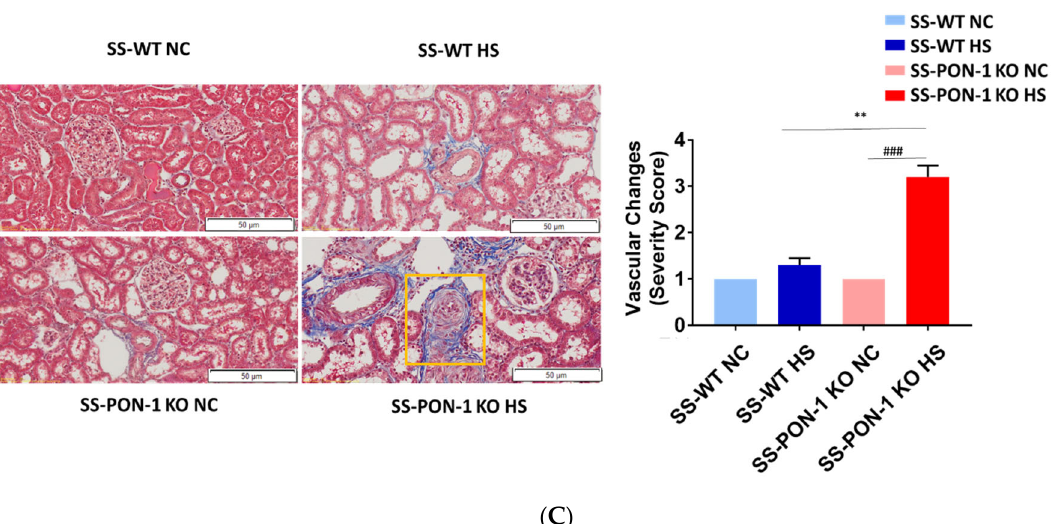
Figure 6. Targeted mutation of paraoxonases-1 leads to a significant increase in histological changes accompanying renal damage; ( A ) glomerular sclerosis, ( B ) tubular necrosis, and ( C ) vascular changes. Representative H&E histology (right) and quantification (left). SS-PON-1 KO rats show a significant increase in renal injury, compared to SS rats, following 5 weeks on the 8% high-salt diet (N = 6). * p < 0.05, ** p < 0.01, *** p < 0.001 vs. high-salt, ### p < 0.001 vs. normal chow.